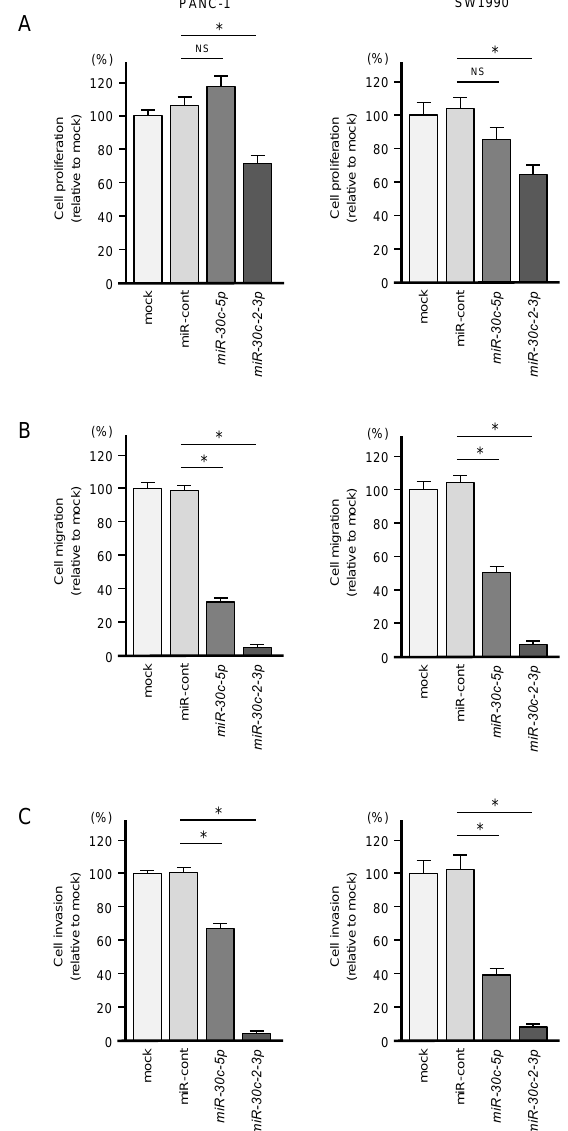
Figure 2. Tumor-suppressive roles of miR-30c-5p and miR-30c-2-3p in PDAC cell lines. ( A ) Cell proliferation was measured by the XTT assay. Data were collected 72 h after miRNA transfection (* p < 0.0001). ( B ) Cell migration was assessed with a membrane culture system. Data were collected 48 h after seeding the cells into chambers (* p < 0.0001). ( C ) Cell invasion was determined 48 h after seeding miRNA-transfected cells into chambers using Matrigel invasion assays (* p < 0.0001).